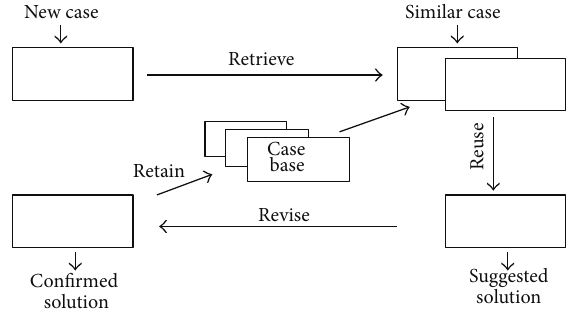
Figure 1: The flowchart of